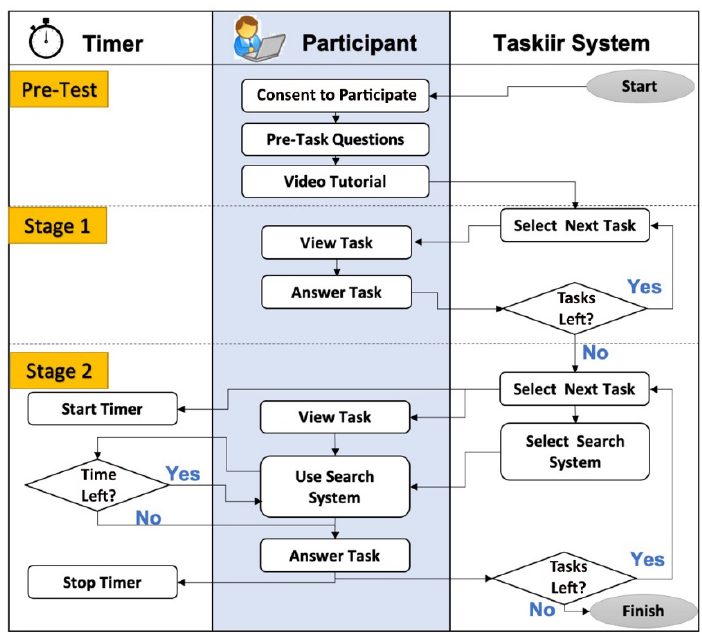
Figure 1 Process flow diagram of the